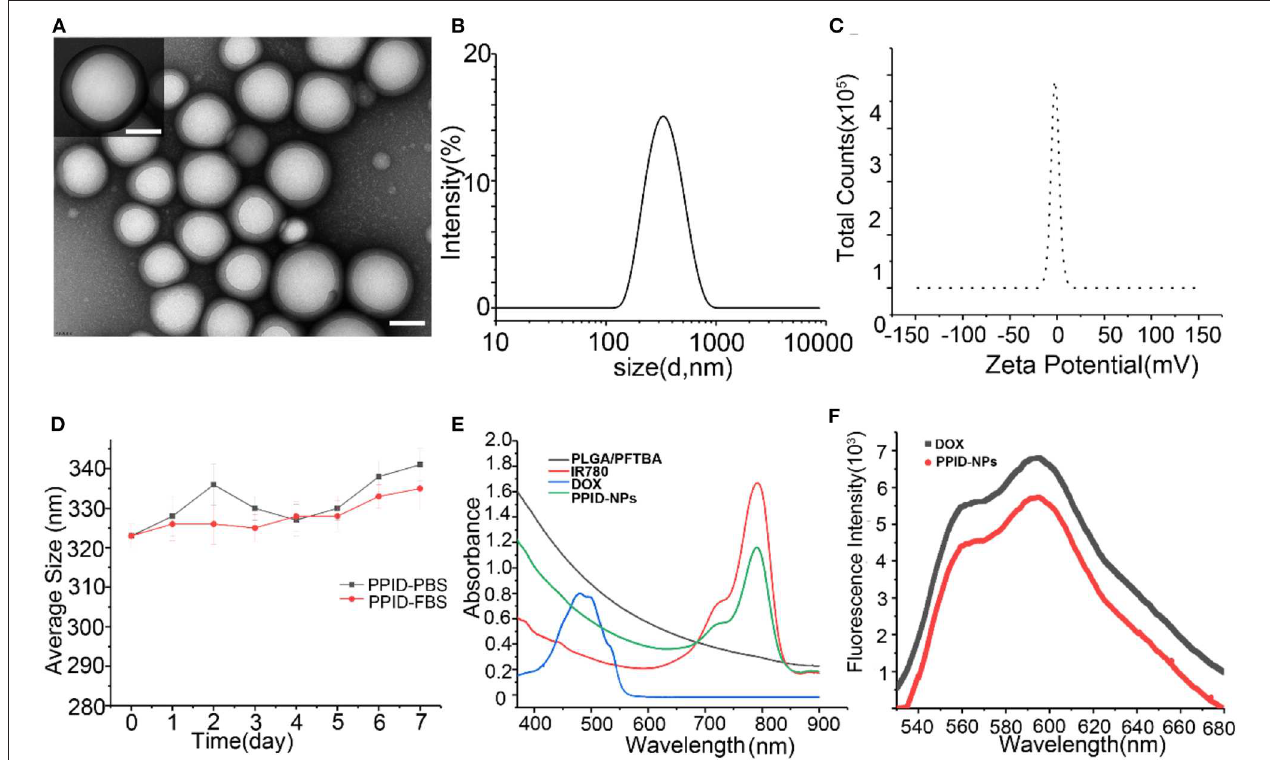
FIGURE 2 | (A) TEM images of PPID-NPs (scale bar, 100nm). (B,C) Size and zeta intensity distributions of PPID-NPs. (D) Average size of PPID-NPs in 1 × PBS or 10%FBS for 7 days. (E) UV-vis-NIR absorption spectra of free IR780, DOX, PLGA/PFTBA NPs, and PPID-NPs. (F) Fluorescence spectra of PPID-NPs and DOX.